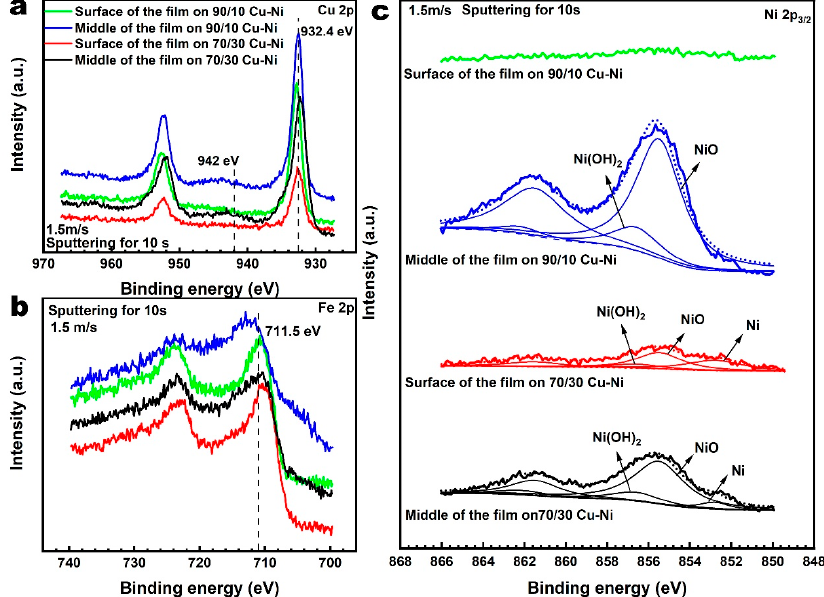
Figure 8. Cu 2p spectra ( a ), Fe 2p spectra ( b ), and Ni2p 2/3 spectra ( c ) after sputtering for 10 s for the 90/10 copper–nickel sample and the 70/30 copper–nickel sample after the 10-day erosion–corrosion test at 1.5 m/s.